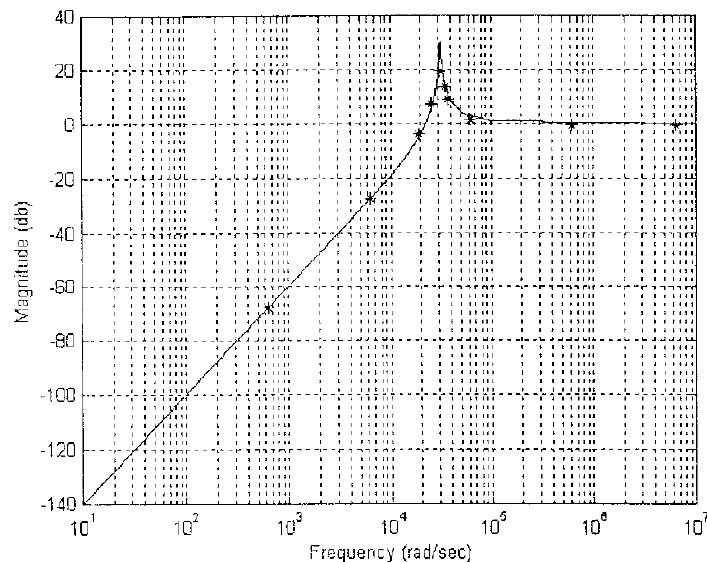
FIGURE 3 Calculated (____) and simulated (**) characteristic of the current-mode HPF obtained from I out 1 with V in 1 ¼ V in 2 ¼ I in 2 ¼